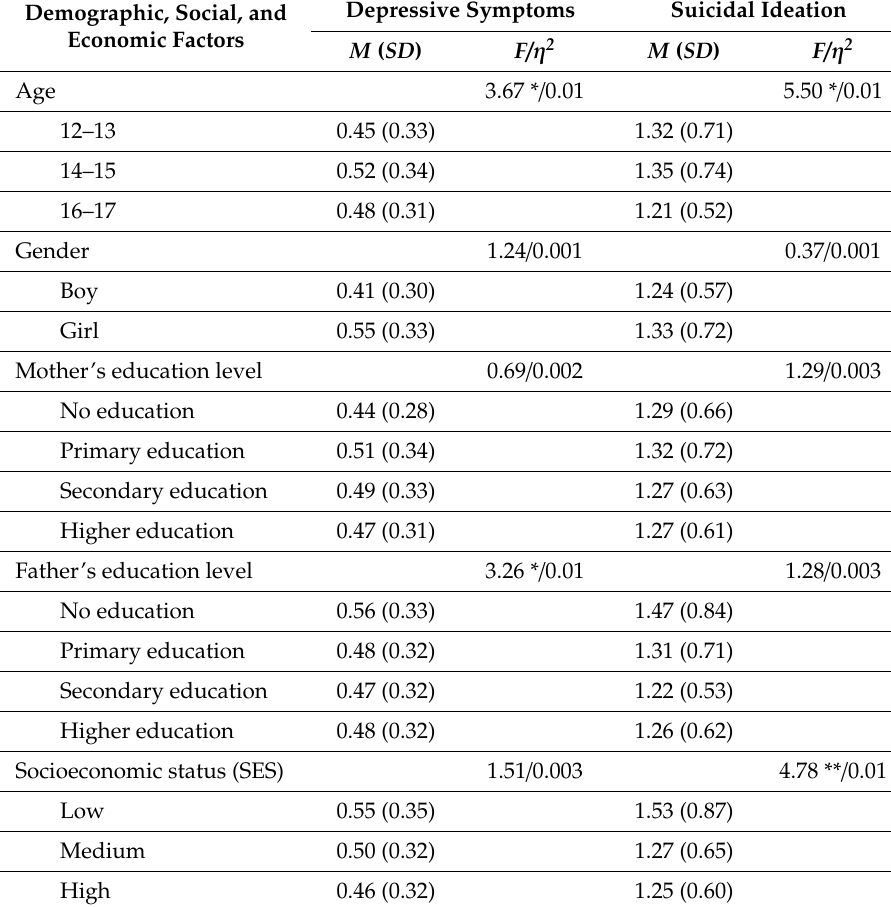
Table 4. Multivariate analysis of variance (MANOVA) for the non-referred sample ( n = 1401). Demographic, Social, and Economic